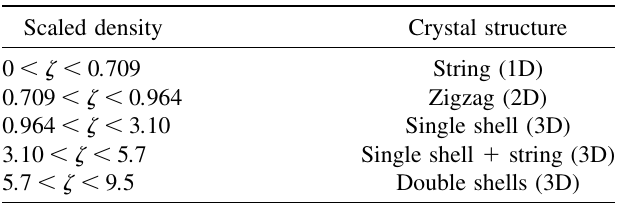
TABLE I. Transition densities of coasting Coulomb crystals confined in the time-independent potential [7]. Scaled